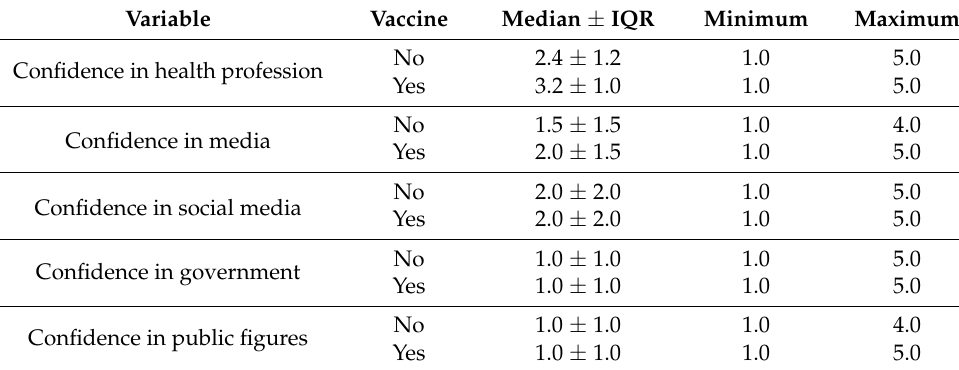
Table 4. Descriptive statistics for confidence in information providers.